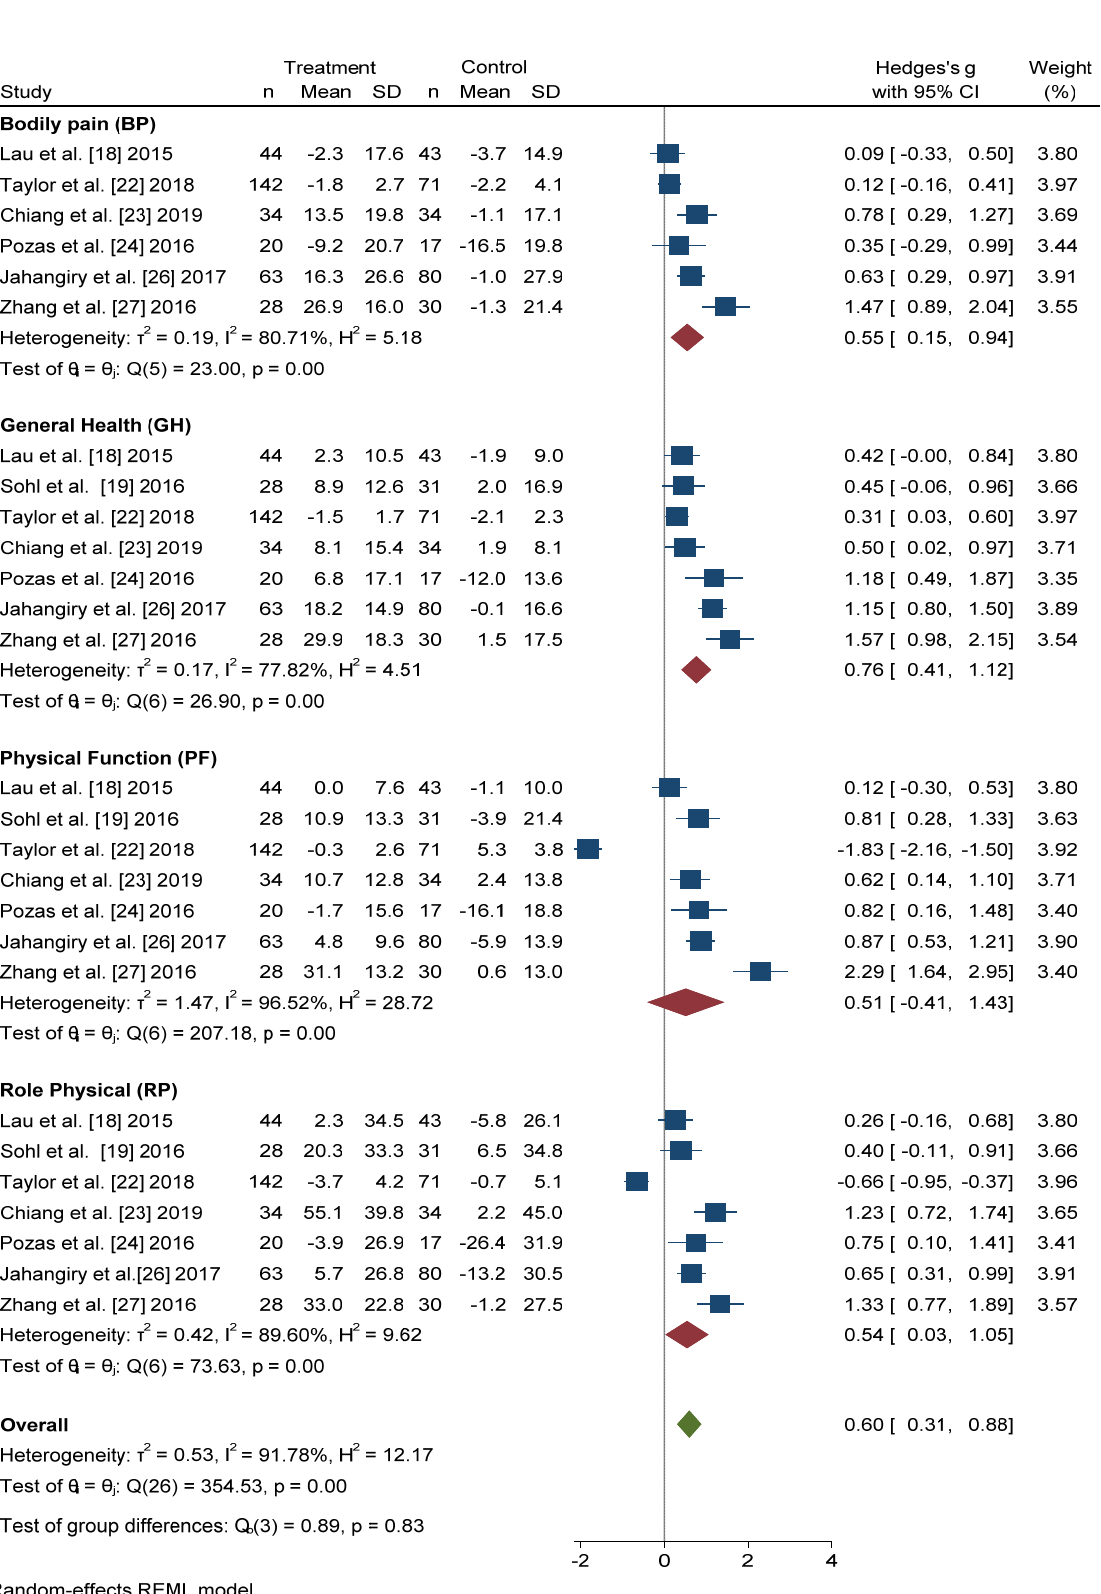
Figure 4. Forest plot of the physical health scores. Blue navy square centered at the point estimate of the effect size, with a horizontal line extending on either side of the square, representing the 95% confidence interval of the point stimate. Red diamond represents a confidence interval for each dimensions and green diamond represents a confidence a confidence interval for the overall effect size . REML: Restricted maximum-likelihood.